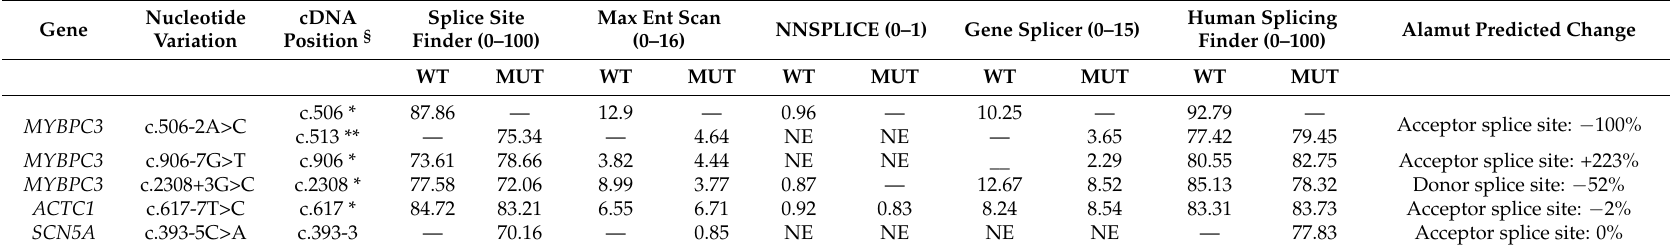
Table 2. Splicing analysis results obtained with five algorithms and the Alamut